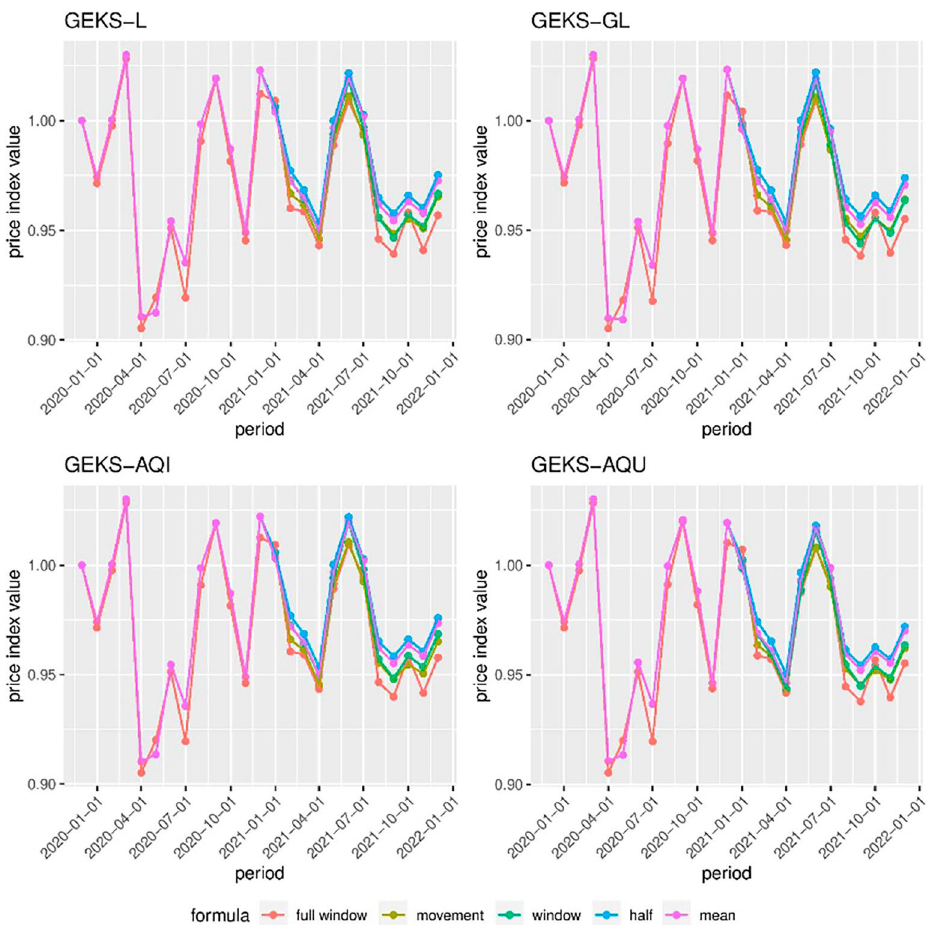
Figure A4. Comparison of G IDT indices (splicing methods vs full time indices) for joghurt